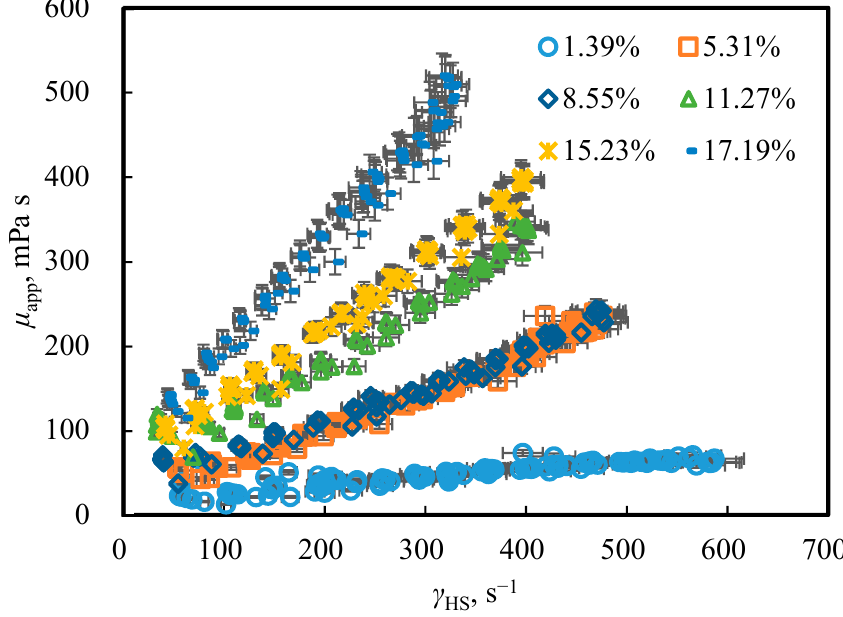
Figure 5. Representation of shear rate and apparent viscosity for CO 2 hydrate concentrations from 1.39 to 17.19 vol%.